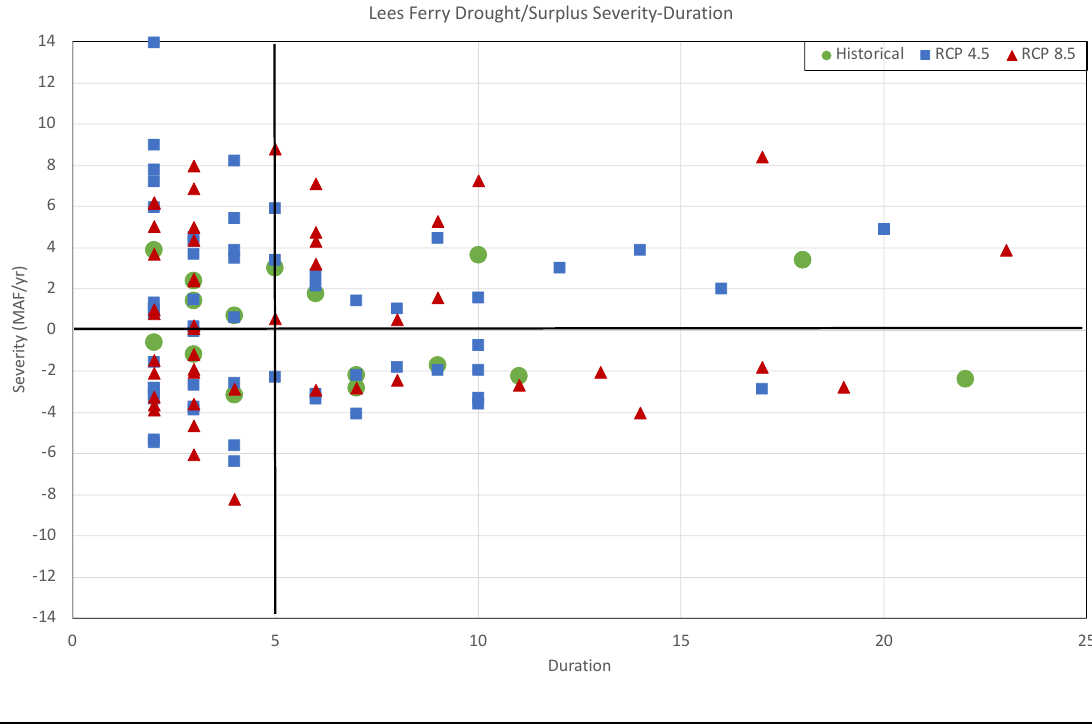
Figure 6. Scatter plot of duration vs. severity for historical and all RCP 4.5 and 8.5 scenarios at Lees Ferry. (Note: 1 MAF = 1233 million cubic m).